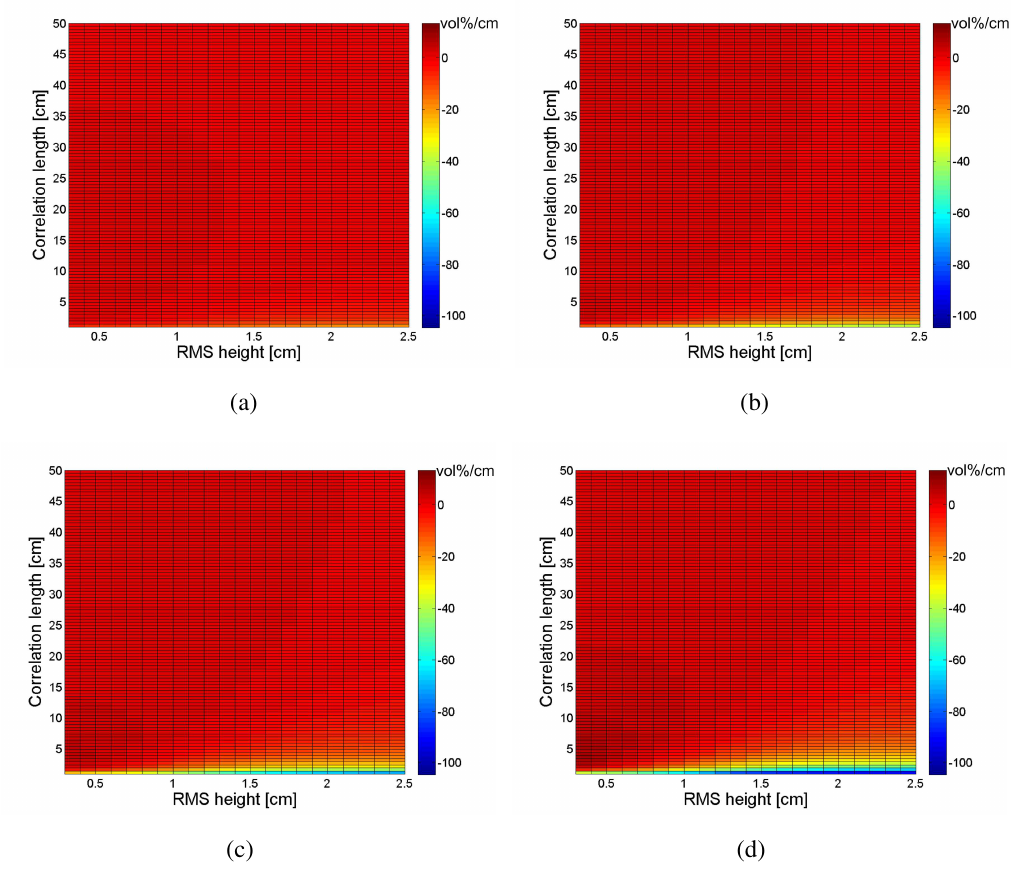
Figure 3. Sensitivity of the soil moisture retrieval to correlation length (vol%/cm) for an ASAR VV configuration and a moisture content of (a) 5 vol%, (b) 15 vol%, (c) 25 vol%, and (d) 35